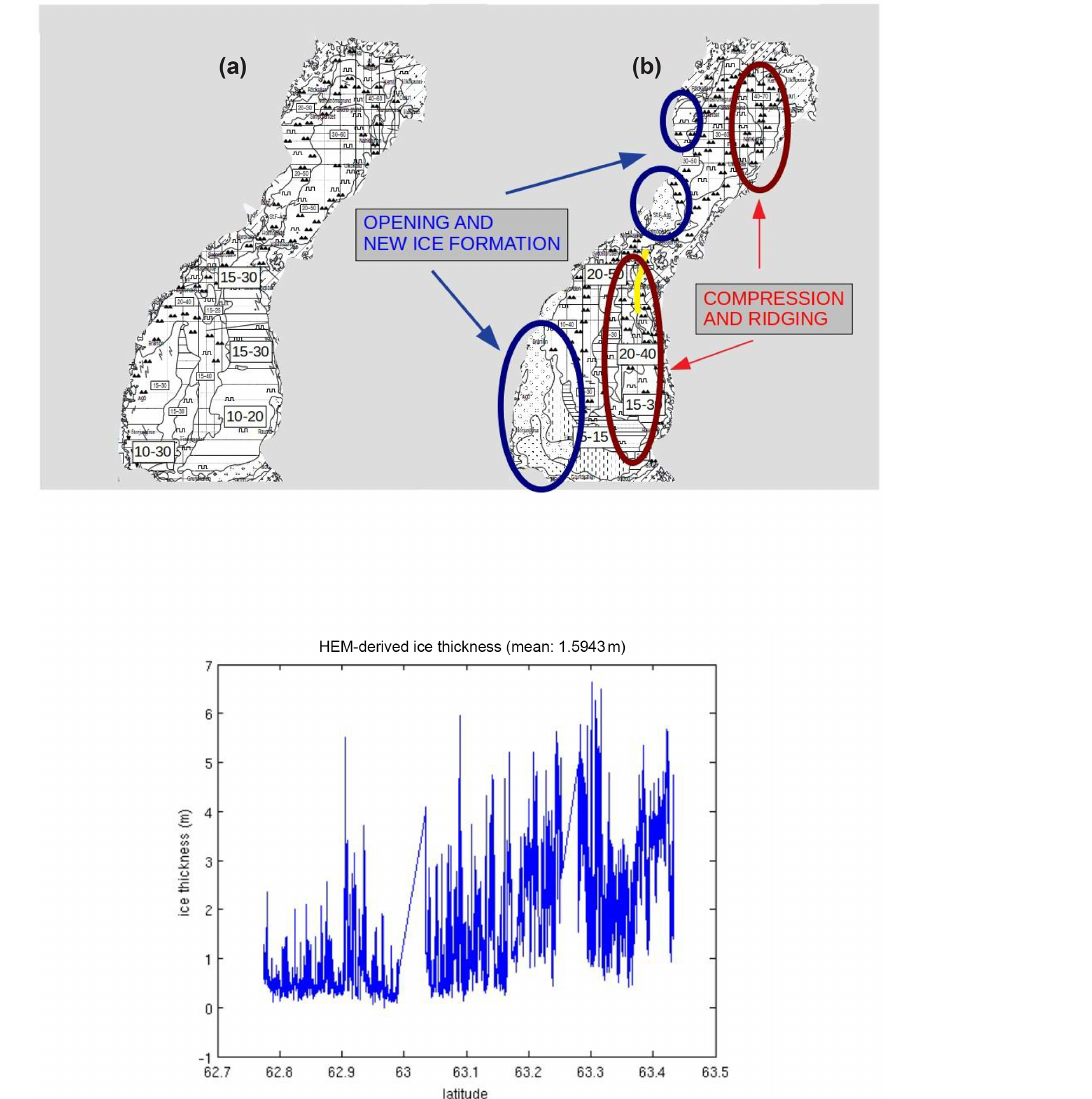
Figure 9. Ice charts before and after the major compression event in February 2011. Regions experienced opening and compression/ridging are indicated using blue and red circles respectively. The lower panel depicts ice thickness along the yellow transect shown in the ice chart